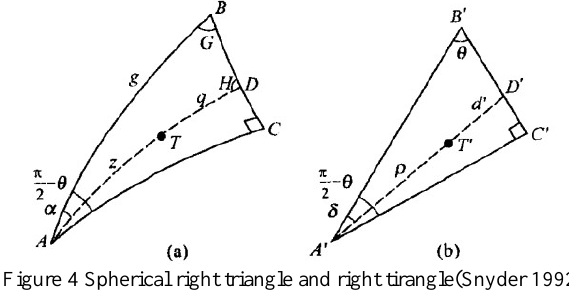
Figure 4 Spherical right triangle and right tirangle(Snyder 1992)